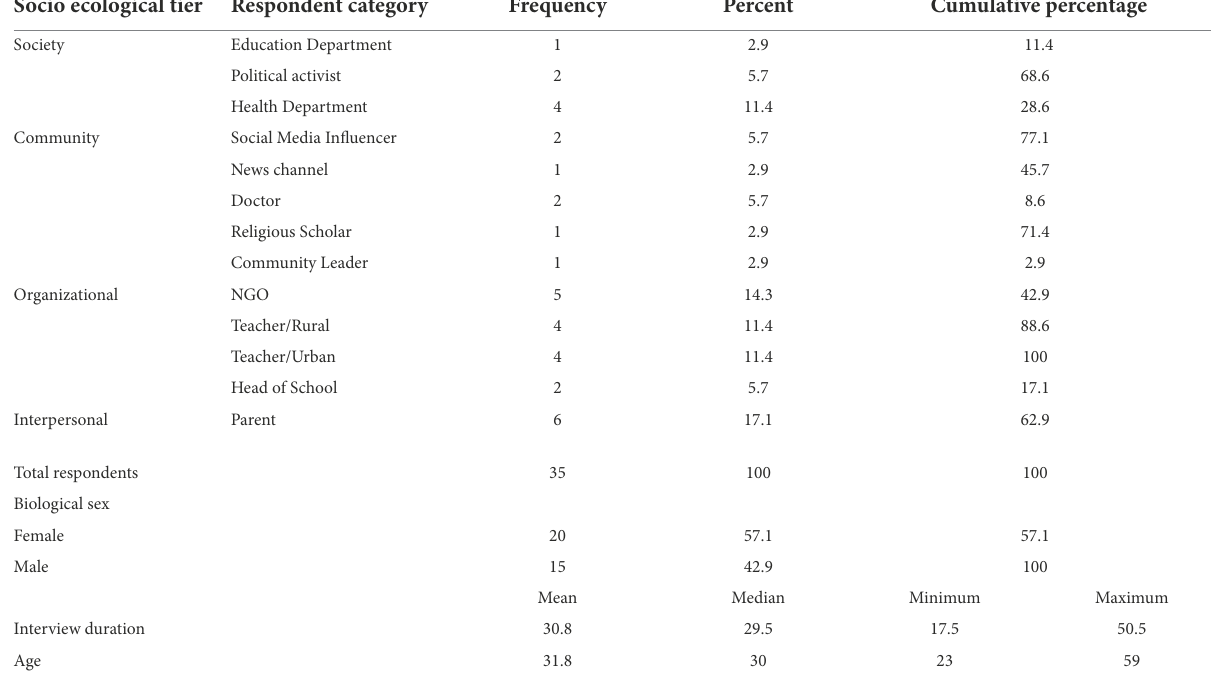
TABLE 1 Respondent category, biological sex, interview duration, and age descriptive statistics. Socio ecological